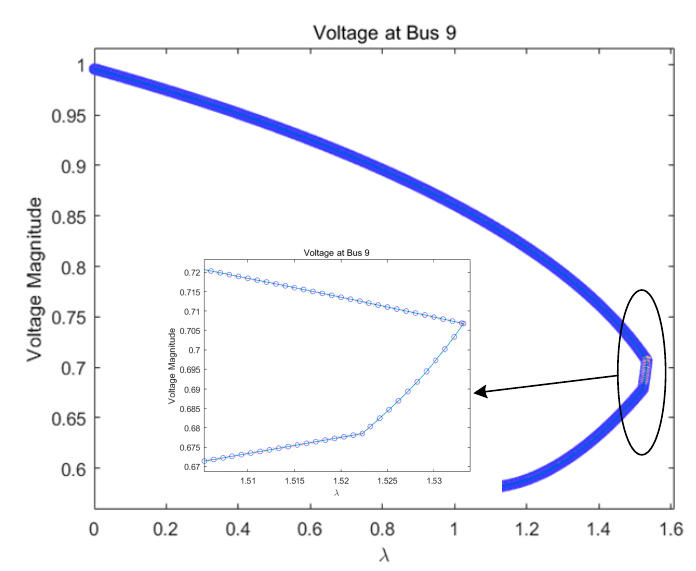
Figure 7. Step size s = 0.001 for conventional predictor-corrector method.